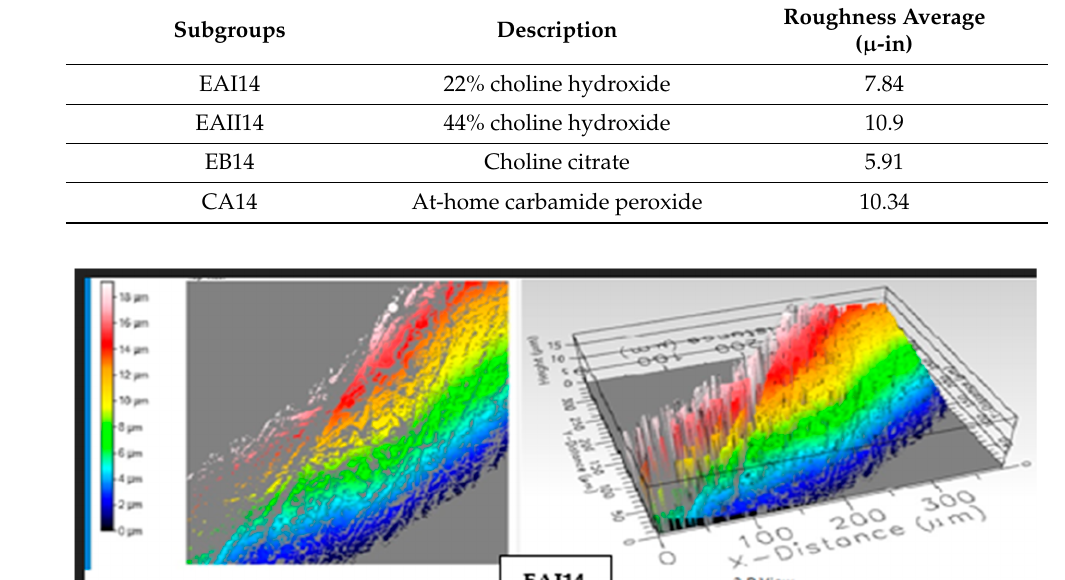
Table 5. Roughness average of the tooth samples in the four subgroups.